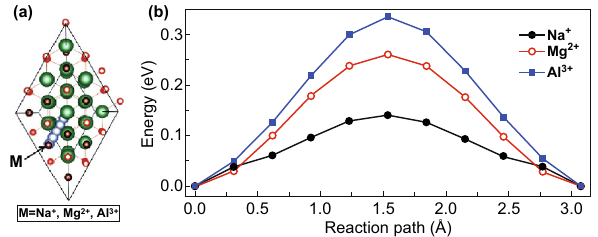
Fig. 5 a Considered ion migration pathway and b corresponding energy profiles of Na + ‏ , Mg 2+ ‏ , and Al 3+ . Reprinted with permission from Ref. [52]. Copyright © (2019) AIP Publishing LLC